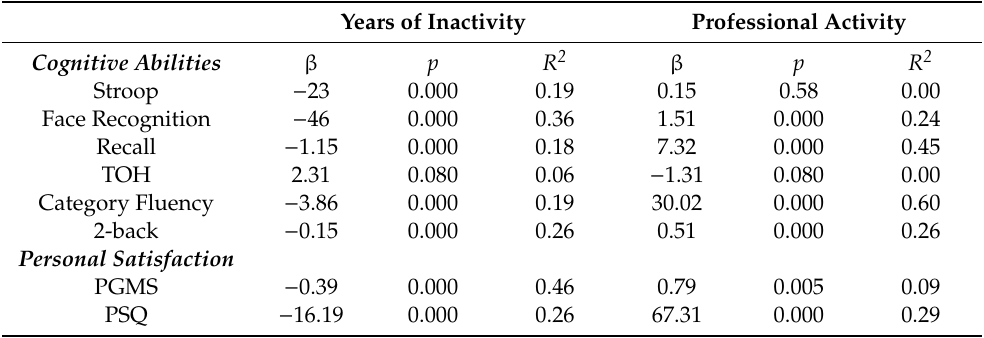
Table 2. Regression models for years of inactivity and professional activity on di ff erent measures of cognitive abilities and personal